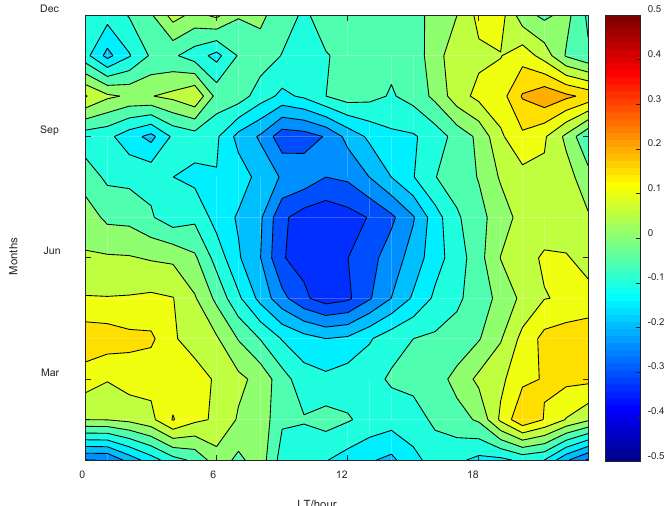
Figure 3. Diurnal variation of TEC longitude difference index R e/w in East Asia in 2015, a high solar activity year.